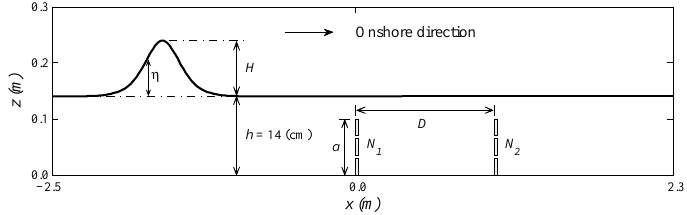
Figure 2. Details of numerical wave flume and definitions of variable used for dual-slotted-barrier configurations.